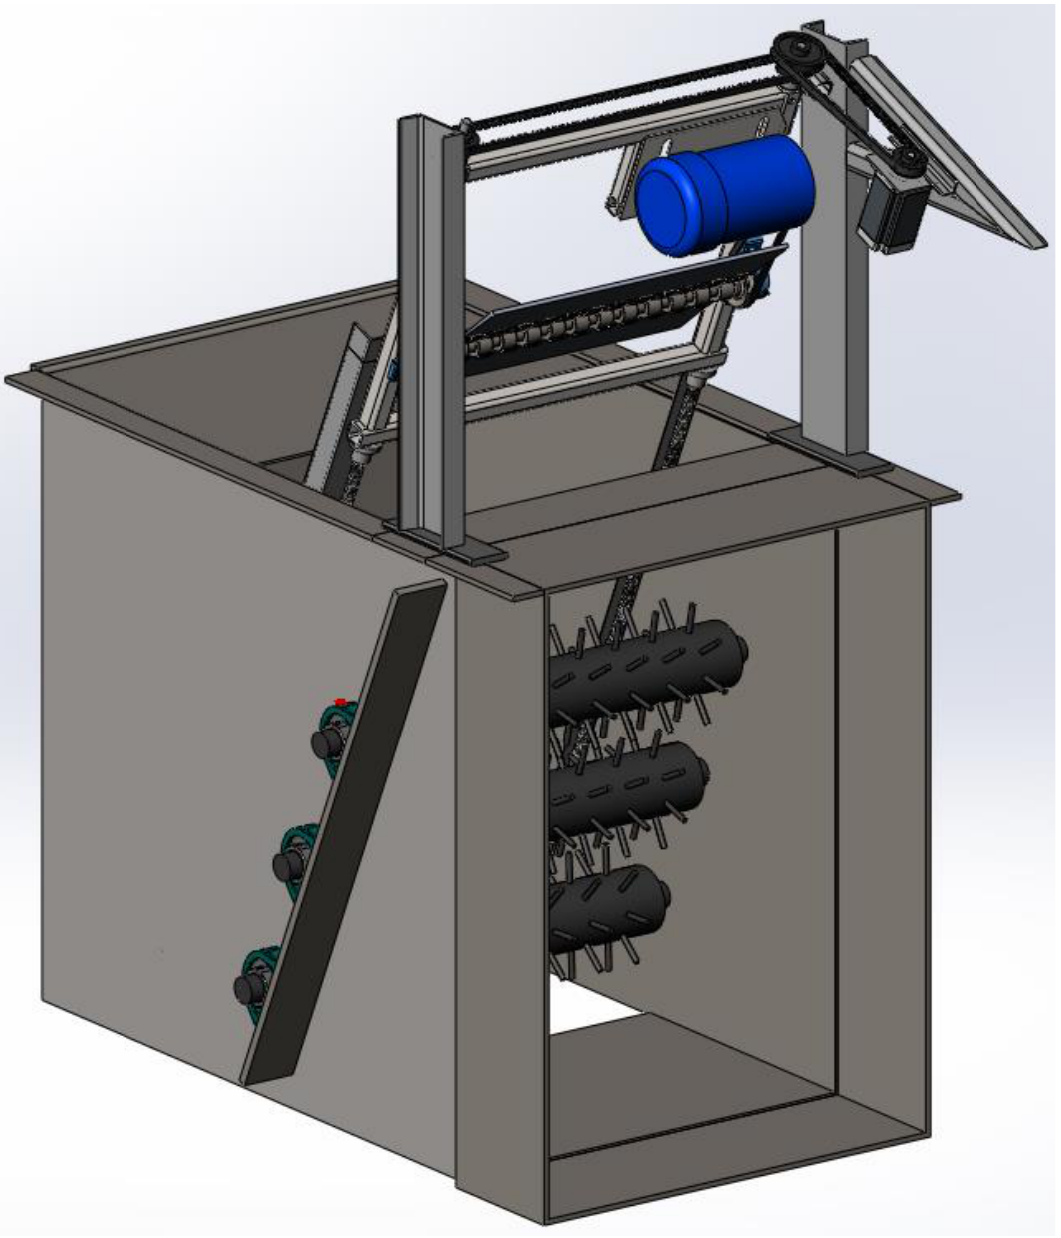
Figure 5. 3D model of the Texas A&M University-designed brush-based plastic removal mechanism installed on a mini module feeder.